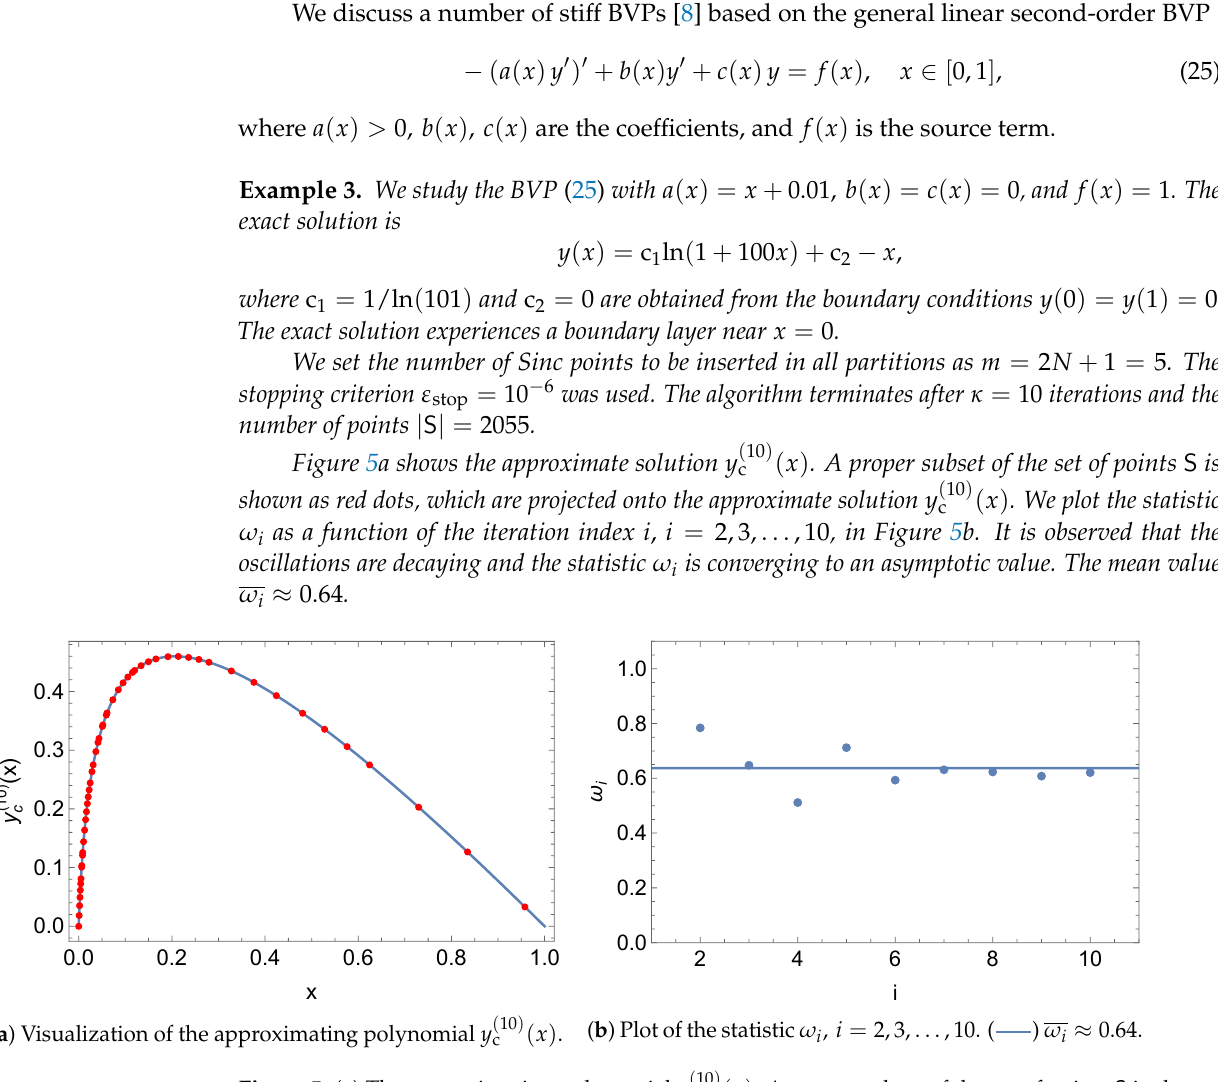
Figure 5. ( a ) The approximating polynomial y ( b ) Plot of the statistic ω i . ( ) ω i ≈